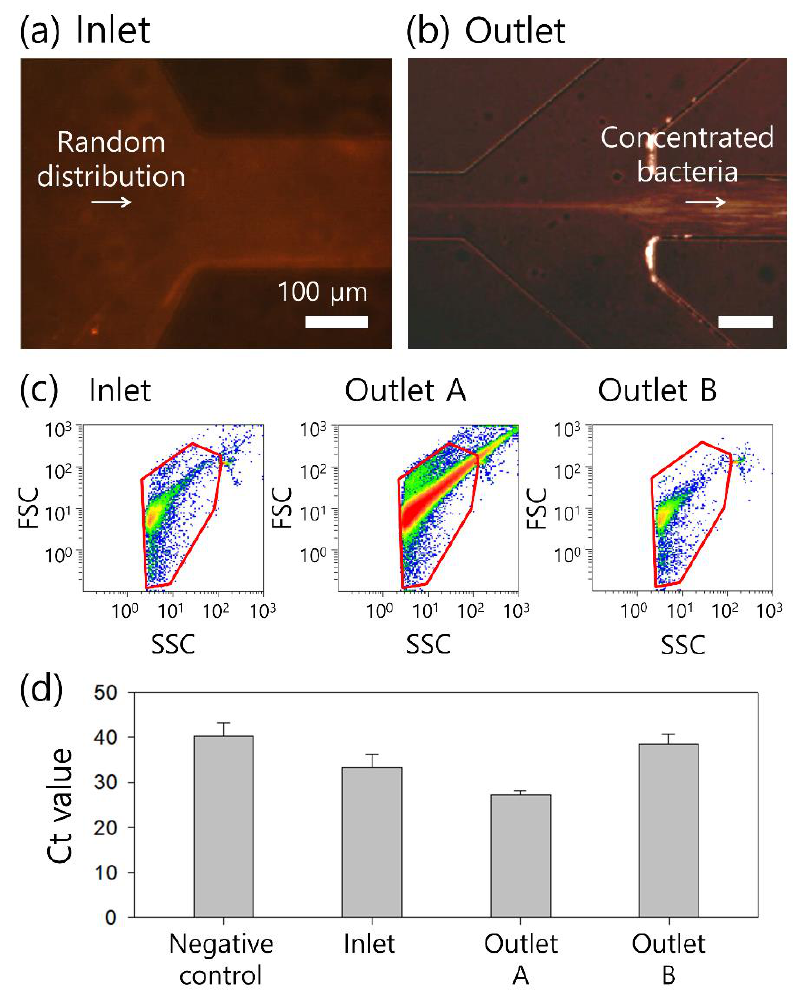
Figure 5. Concentration of bacteria cells at an injection flow rate of 20 μL/min and FF of 40 at the ( a ) inlet and ( b ) outlet after the concentration process. ( c ) Flow cytometric scattergrams before and after the concentration process at the inlet, outlet A, and outlet B, respectively. ( d ) Ct values of RT-LAMP assay before and after the concentration process.